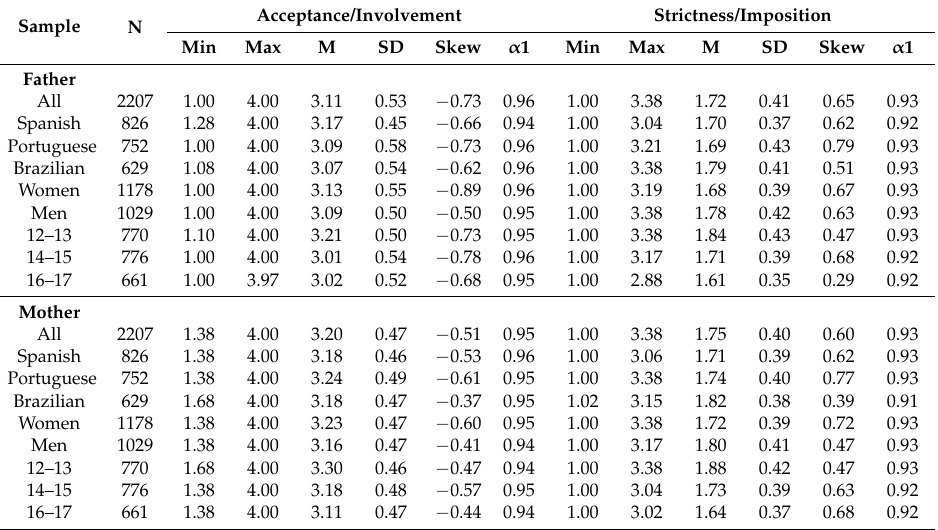
Table 1. Sample distribution of fathers’ and mothers’ parenting practices by country, sex, and age.